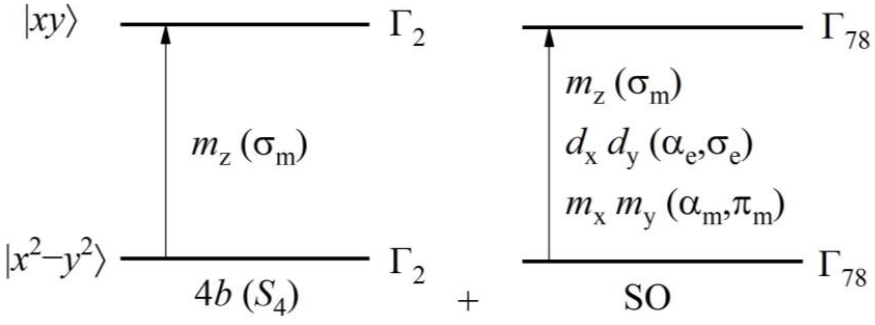
Figure 3. Schematic diagram of Cu 2+ -ion levels and optical transitions responsible for the lowest-frequency 4 b exciton line. Table 1. Experimental values of integral absorption intensities I j = ∫ 𝑘(𝜈)𝑑𝜈 , j = α, σ, π (in cm −2 ) of the exciton spectral line at 1.405 eV for paramagnetic CuB 2 O 4 at T = 25 K in zero external magnetic field, at the α, σ, and π polarizations.